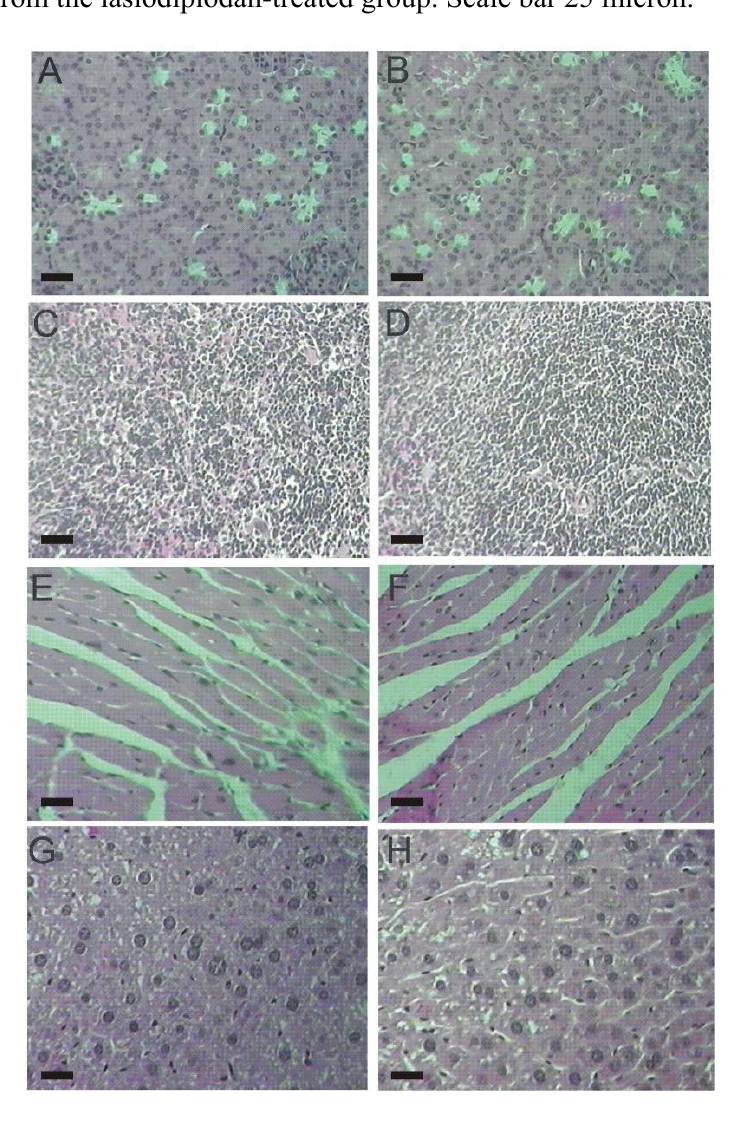
Figure 4. Histological tissue sections from male mice (100  ). ( A ) kidney from the control group; ( B ) kidney from the lasiodiplodan-treated group; ( C ) spleen from the control